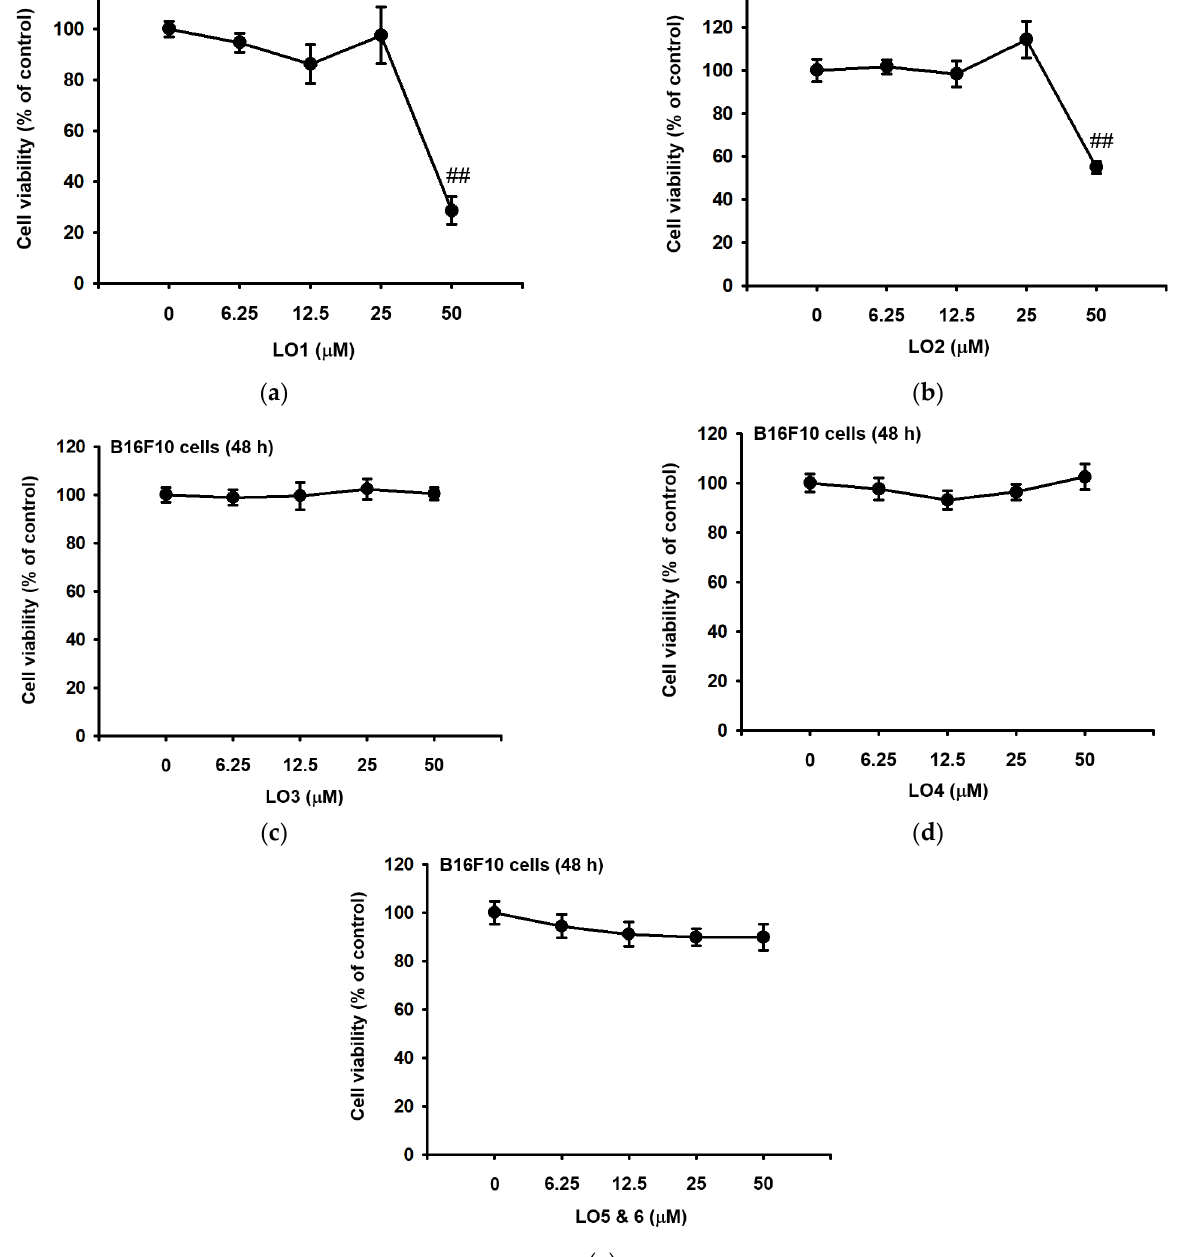
Figure 3. The cell viability was examined by conventional MTT assay. B16F10 cells melanoma were plated in 96well plates and treated with each LO. We confirmed the cytotoxicity of LO1 ( a ), LO2 ( b ), LO3 ( c ), LO4 ( d ), and LO5 and 6 ( e ) for 48 h. Values represent the mean ± standard deviation (SD) of three independent experiments. ## p < 0.01 compared with normal group via Mann-Whitney U test.